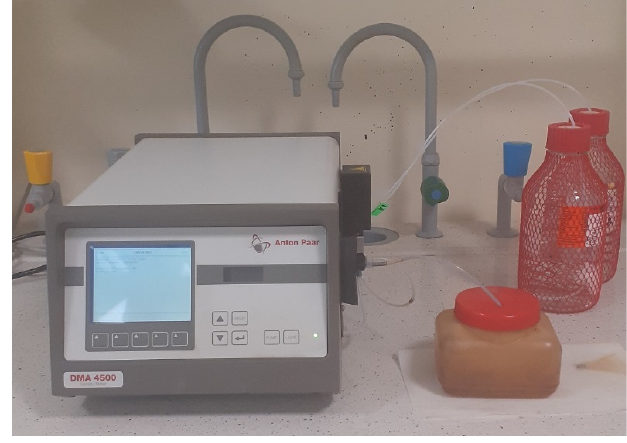
Figure 7. The Anton Paar DMA 4500 used in the study (photo. M. Szmukała).